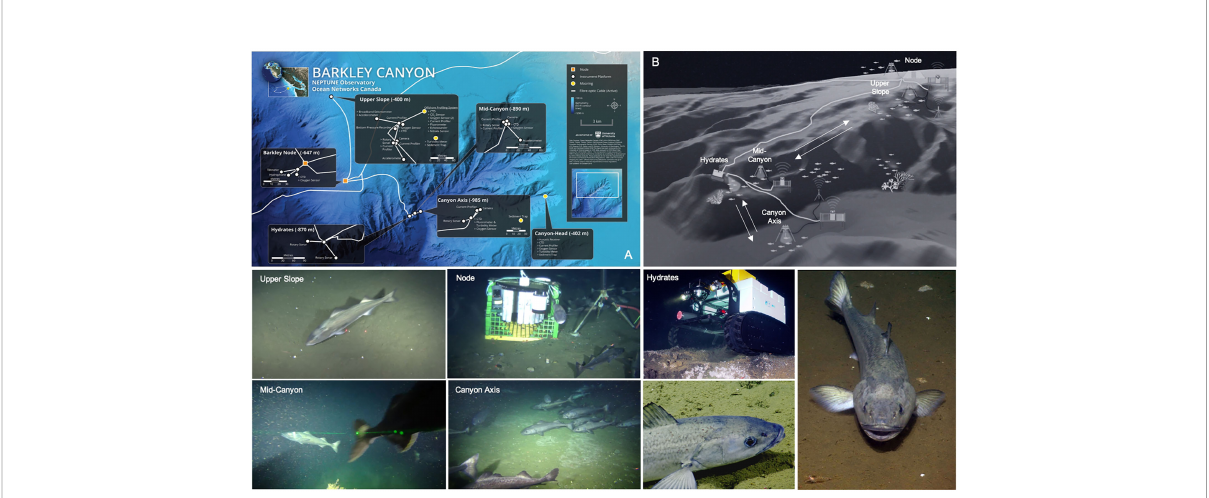
FIGURE 1 Map (A) , schematic (B) and photographs depicting the study area in Barkley Canyon, NE Paci fi c, and the NEPTUNE cabled observatory infrastructure. Video imagery used in this study was limited to 3 out of 5 long-term monitoring sites, Upper Slope (420 m), Canyon Axis (985 m) and Node (620 m). Screen grabs (labeled Upper Slope, Node and Axis) represent the variable video fi eld of view conditions of the three locations used in our